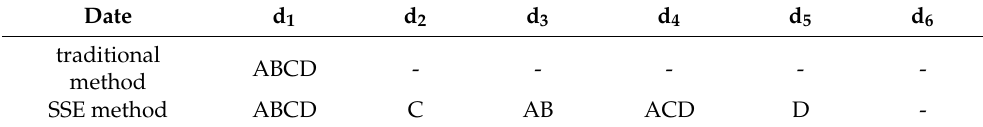
Table 3. Comparison of samples selection via traditional method and SSE method based on Figure